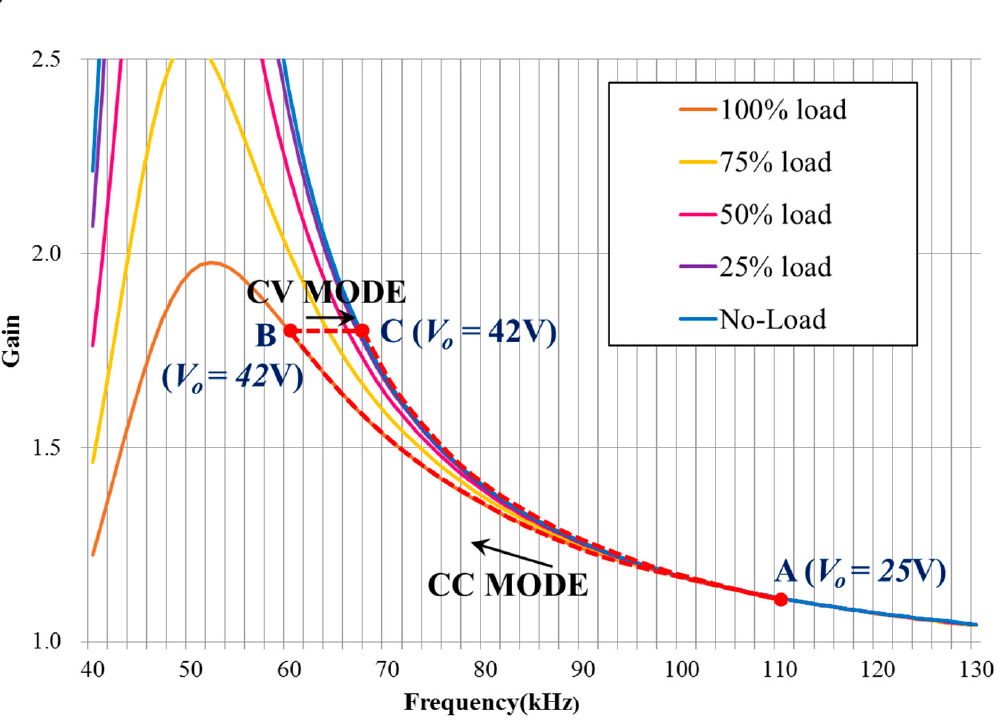
Figure 9. The operation trajectory of the entire charging process.